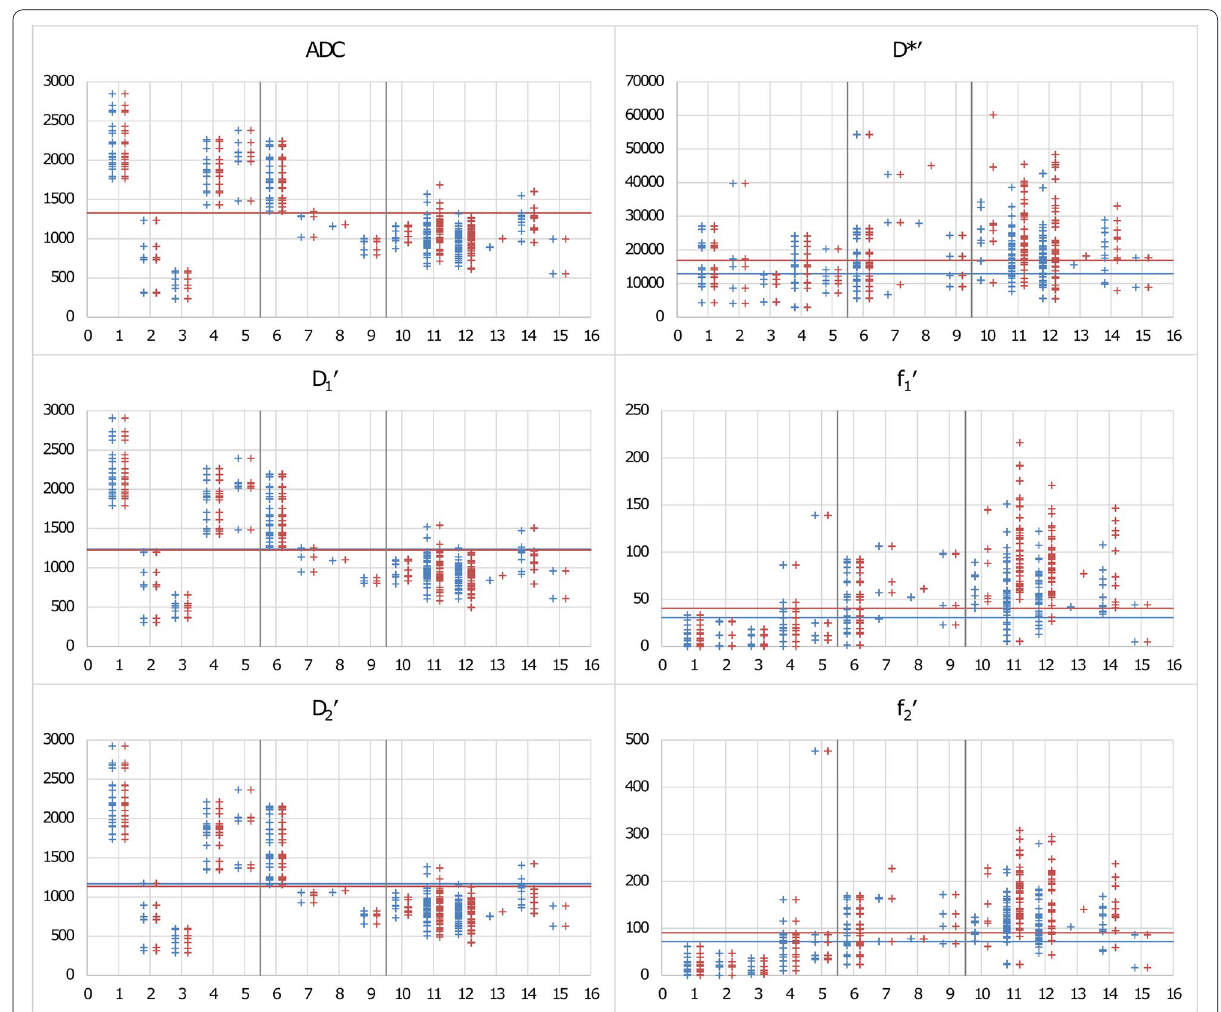
Fig. 2 Overview to ADC, D 1 ′ , D 2 ′ , f 1 ′ , f 2 ′ , and D * ′ values grouped according to different lesion types. The group and subgroup designations are explained in Table 1. Blue data points belong to vital tumour regions of interest (VT-ROIs), red to hot spot ROIs (HS-ROIs). For each parameter, the cutoff points (see Tables 5 and 6) are also given, as blue line for VT-ROIs and red line for HS-ROIs. Apparent diffusion coefficient (ADC), D 1 ′ , D 2 ′ , and D * ′ are given in units of 10 -6 mm 2 /s, f 1 ′ , and f 2 ′ values are given in units of 10 -3 . It can be seen that values of ADC, D 1 ′ , and D 2 ′ were typically smaller for group C compared to group A B, for VT- and HS-ROIs. Exceptions were complicated (haemorrhagic/proteinaceous) cyst and haematoma, which + also had low values. Values of f 1 ′ and f 2 ′ were typically larger for group C compared to group A B, especially for HS-ROIs. However, many benign + lesions with suspicious contrast enhancement (group B) also have large